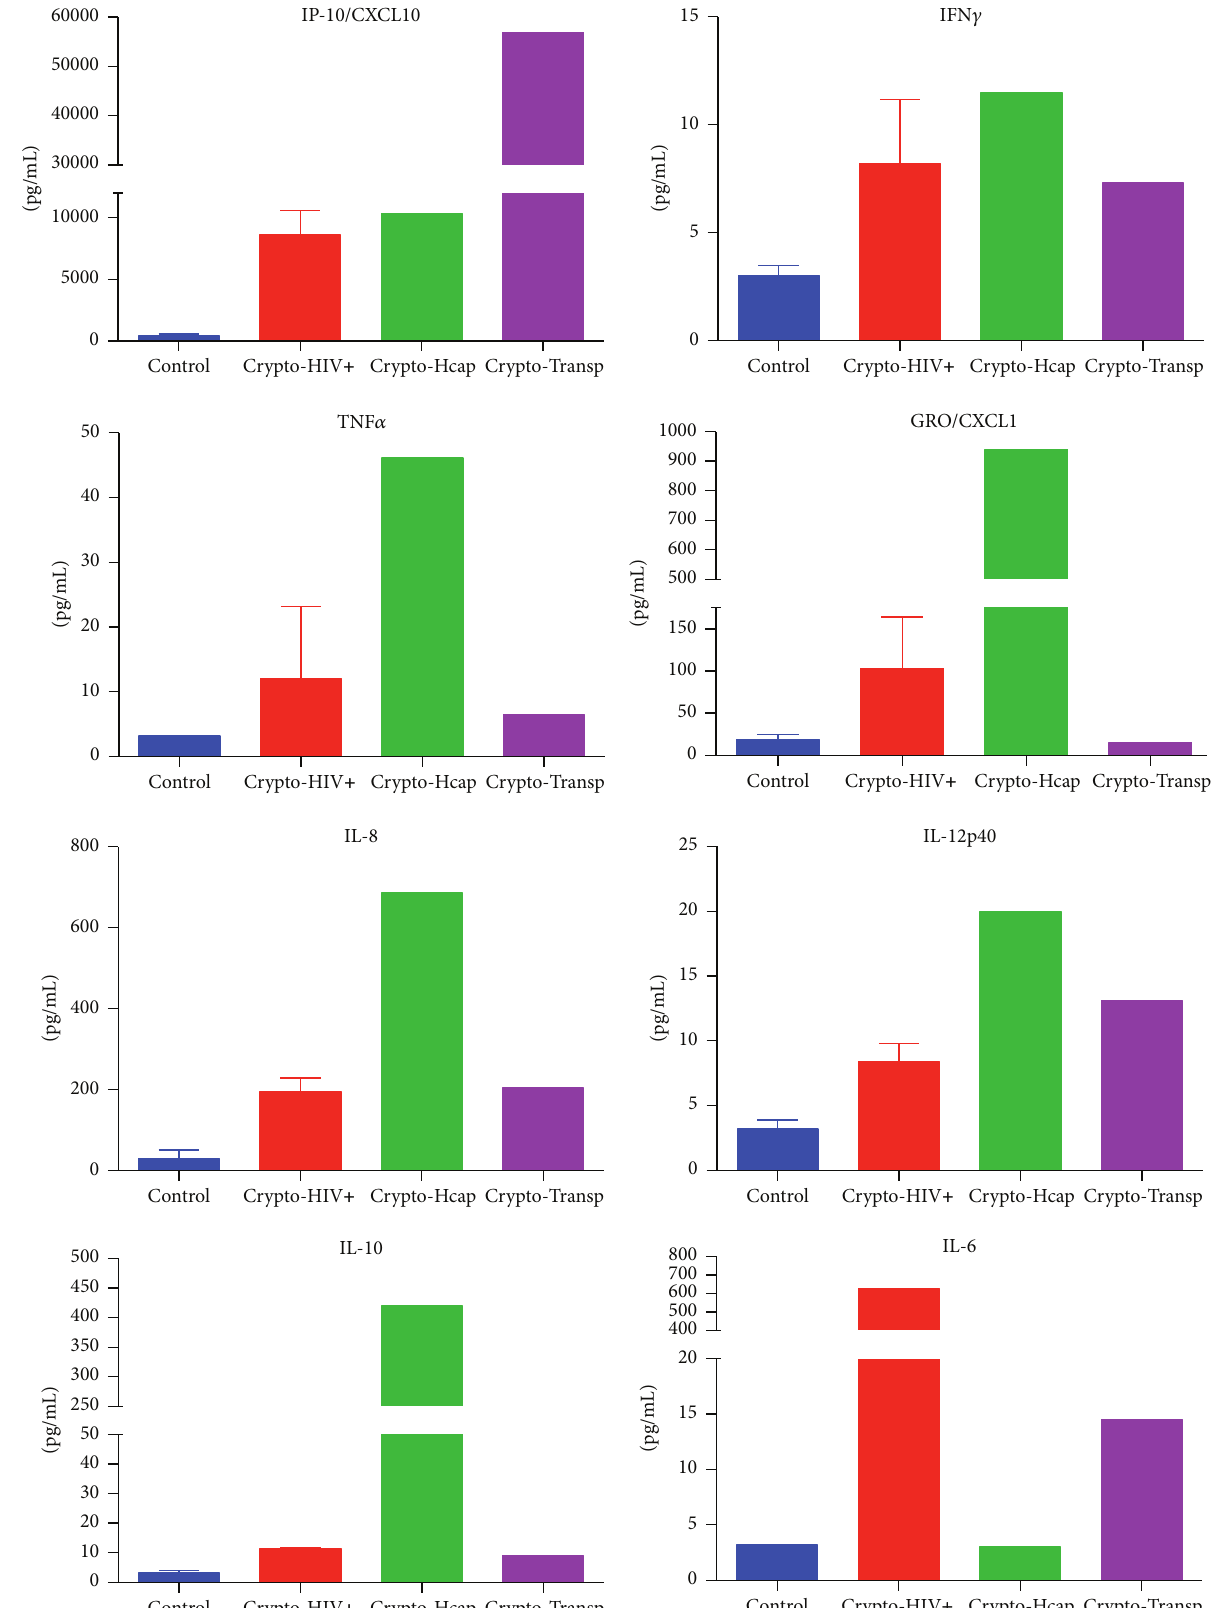
Figure 3: Respective cytokine levels in control ( 𝑛 = 6 ), Cryptococcus in HIV-positive (HIV+, 𝑛 = 2 ), Cryptococcus in our patient (hypocapsular (Hcap), 𝑛 = 1 ), and Cryptococcus after cardiac transplant (Transp, 𝑛 = 1